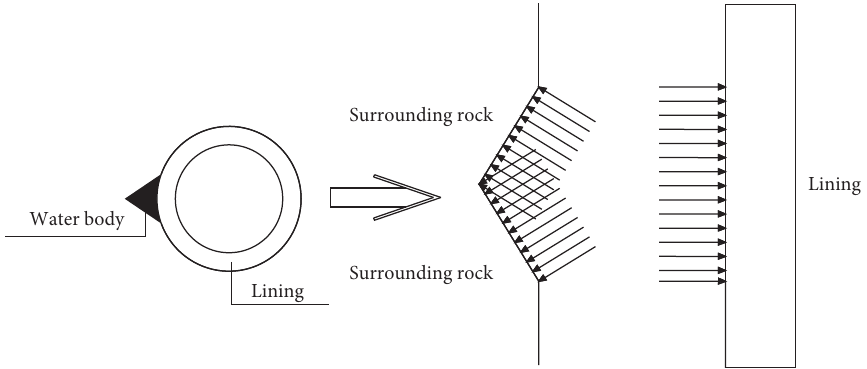
Figure 1: Simplified computational model of the cavity behind tunnel